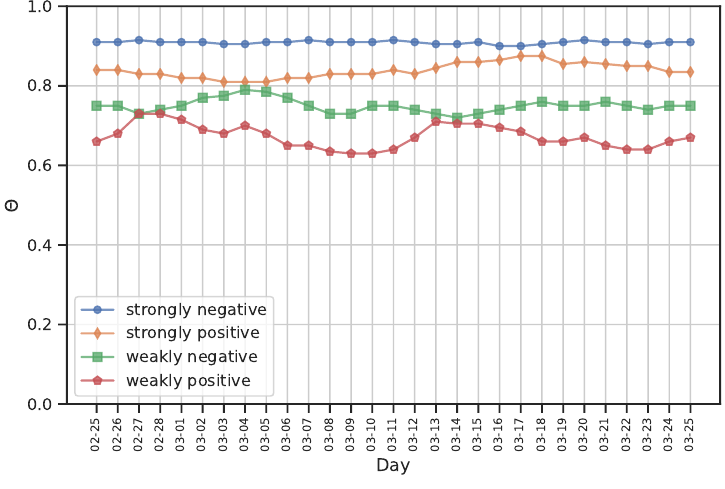
Figure 4. Variation over time of the average value of the sentiment degree associated with each sentiment type. Table 8. Values of some statistic measures computed over the whole time period for sn , sp , wn , and wp